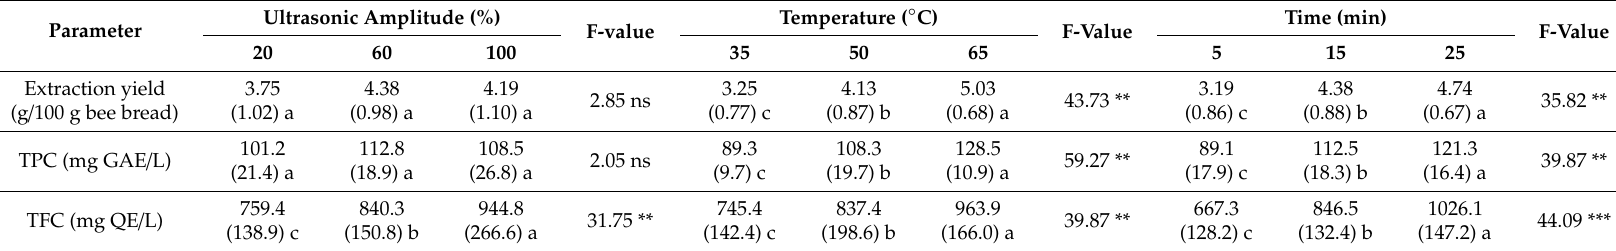
Table 3. ANOVA of the influence of extraction parameters on total phenolic content (TPC), total flavonoid content (TFC) and extraction yield. Mean values and standard deviation.